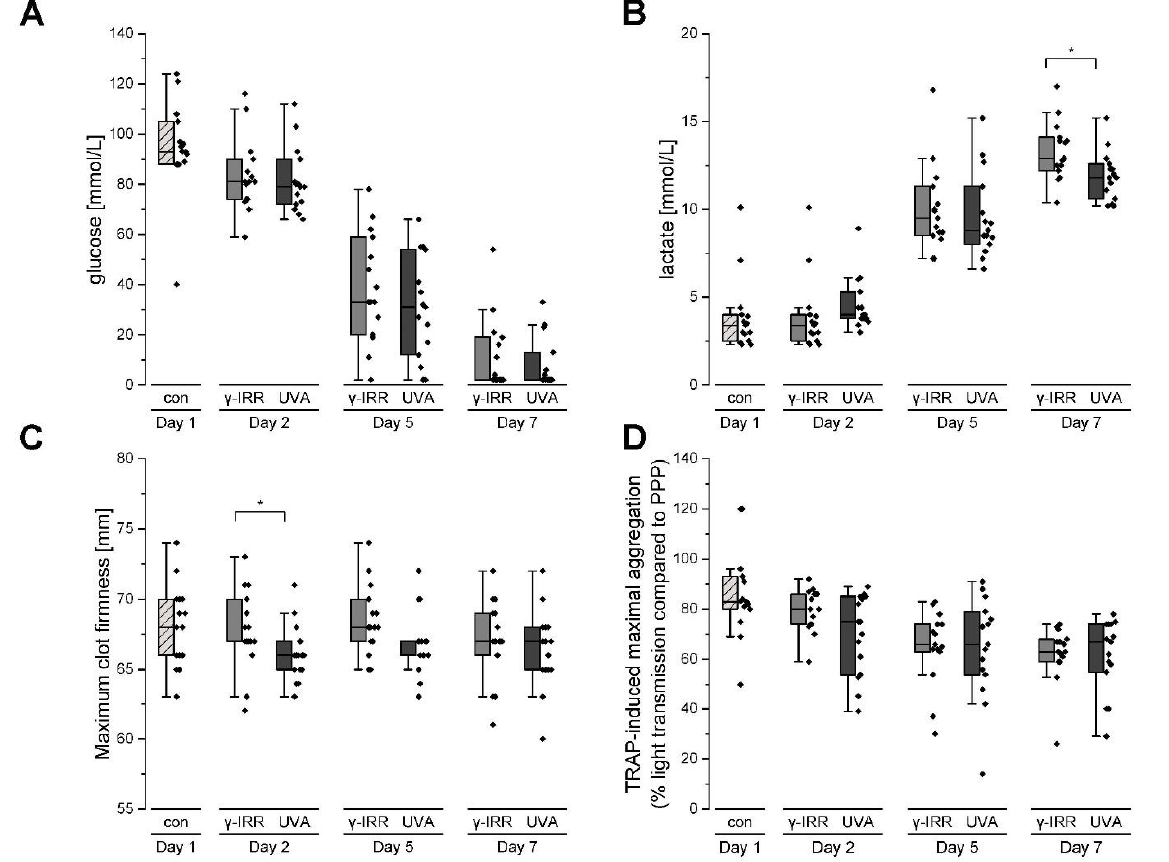
Figure 1. Metabolic changes of platelet concentrates over the storage time for ( A ) glucose and ( B ) lactate. Functional parameters are represented via ( C ) the maximal clot firmness (MCF) and ( D ) the maximal TRAP (thrombin activation peptide)-induced aggregation capacity. Significant differences between γ -IRR (grey) and INTERCEPT (dark grey)-treated PCs are labeled by asterisks (Mann – Whitney U test). Table 1. ( a ): ROTEM data of γ -irradiated and INTERCEPT-treated platelet units. MCF, maximal clot firmness (millimeters); CFT, clot formation time (seconds); SD, standard deviation. ( b ): Aggregom- etry results after collagen and TRAP-6 enhancement. TRAP-6, thrombin receptor agonist peptide 6; MA, maximal aggregation; SD, standard deviation.